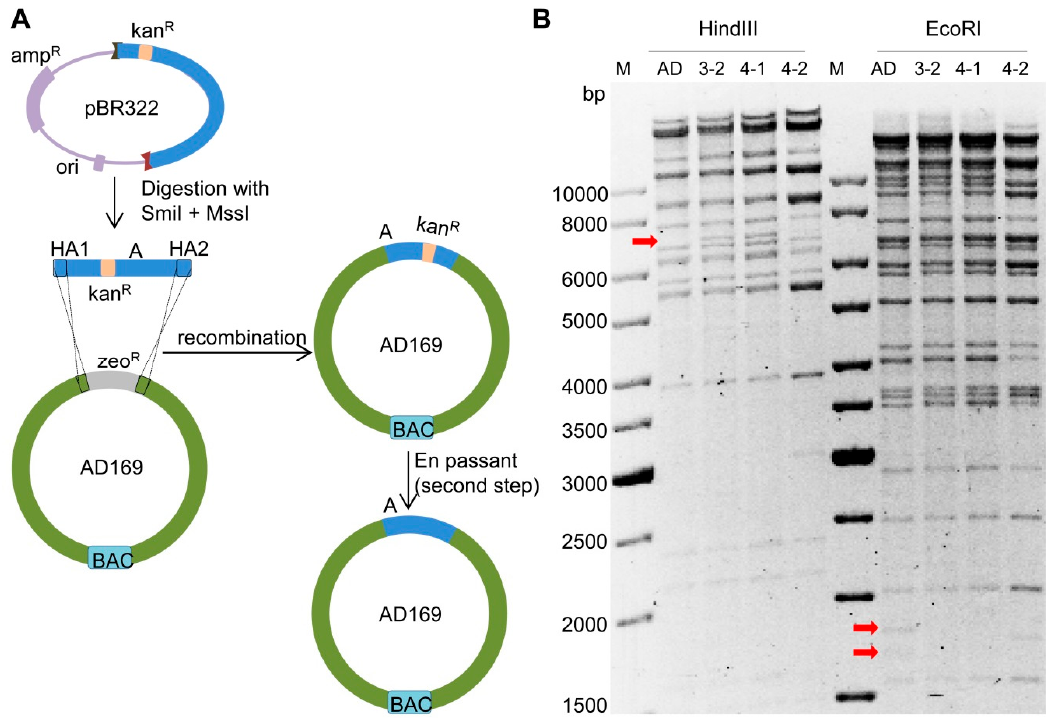
Figure 5. Insertion of fragment ‘A-Ins’ into AD169-a-Del. ( A ) Schematic view of the insertion (paste) strategy. Fragment ‘A-Ins’ was released by digestion with SmiI+MssI. Then it was purified and transformed into competent E. coli strain GS1783 carrying AD169-a-Del3 BAC or AD169-a-Del4 BAC. Clones were selected with kanamycin and chloramphenicol. The kan R /I-SceI cassette was removed by the second step of en passant mutagenesis. ( B ) BAC DNA was analyzed by restriction digestion with HindIII and EcoRI. Arrows indicate the expected alterations in the ‘A’ inserted genome (clones 3-2, 4-1 and 4-2) compared to the parental AD169 (AD) BAC. M, molecular weight standard. Using the same strategy, three additional TB40/E fragments (‘B’, UL69-UL77; ‘C’, UL48A-UL55; and ‘D’, UL56-UL68) were introduced stepwise into AD169:A. The chimeric BACs were named AD169:AB, AD169:ABC, and AD169:ABCD, respectively. The HindIII and EcoRI restriction patterns of all four chimeras (two clones for each chimera, shown in Figure 6) matched the expected patterns. To further verify the correct assembly of the chimeras and exclude fortuitous mutations that might have occurred during the four rounds of copy-paste mutagenesis, the entire AD169:ABCD BAC was subjected to Illumina sequencing. The analysis of the sequence confirmed that the chimera had been constructed as intended and that there were no unwanted mutations.